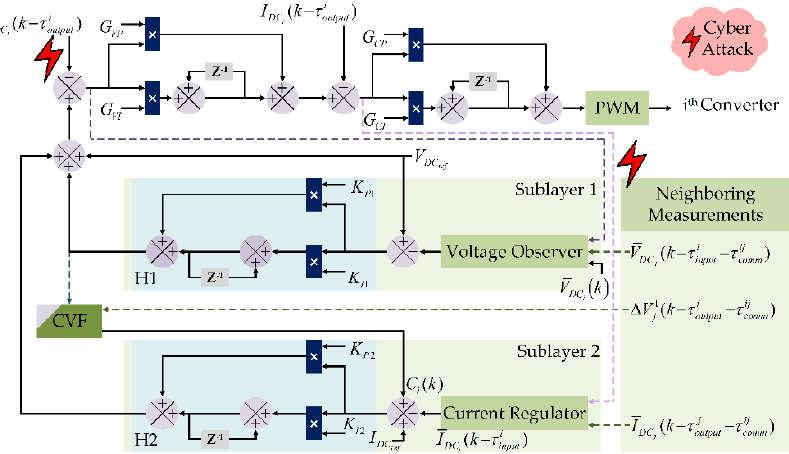
Figure 5. The i th-converter controller for sensors and communication link attacks’ detection in DC microgrids [11].